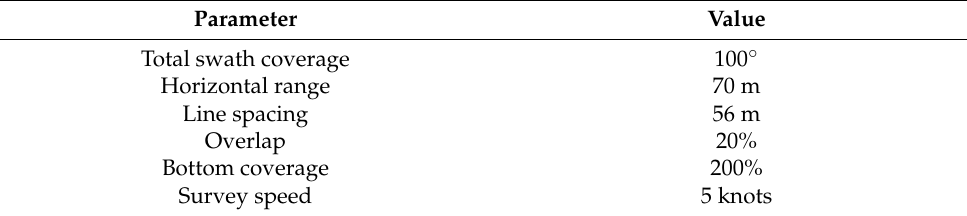
Table 1. Survey project settings applied to bathymetric measurements of the wreck site.